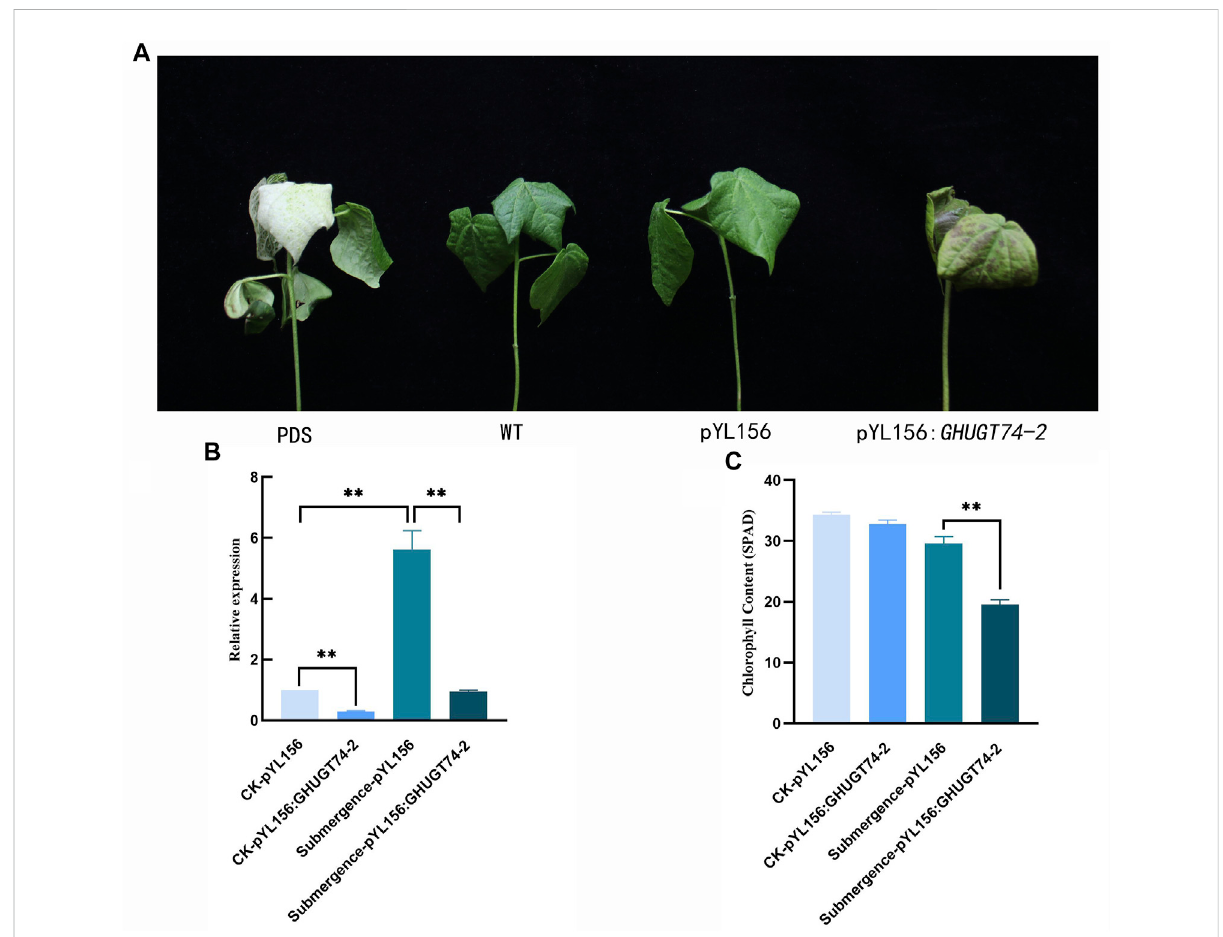
FIGURE 13 Phenotypic and biochemical indicators of cotton after GHUGT74-2 gene silencing under submergence. (A) Phenotypic of cotton after GHUGT74-2 gene silencing under submergence. (B) Expression level of GHUGT74-2 in control and GHUGT74-2 -silenced plants. (C) Chlorophyll content in control and GHUGT74-2 -silenced plants. PDS: albino cotton injected with pYL 156: PDS.; WT: normal growth cotton; pYL 156: blank control cotton injected with pYL 156 vector; pYL156: GHUGT74-2 : silenced cotton injected with pYL 156: GHUGT74-2 . *: p < 0.05, **: p <